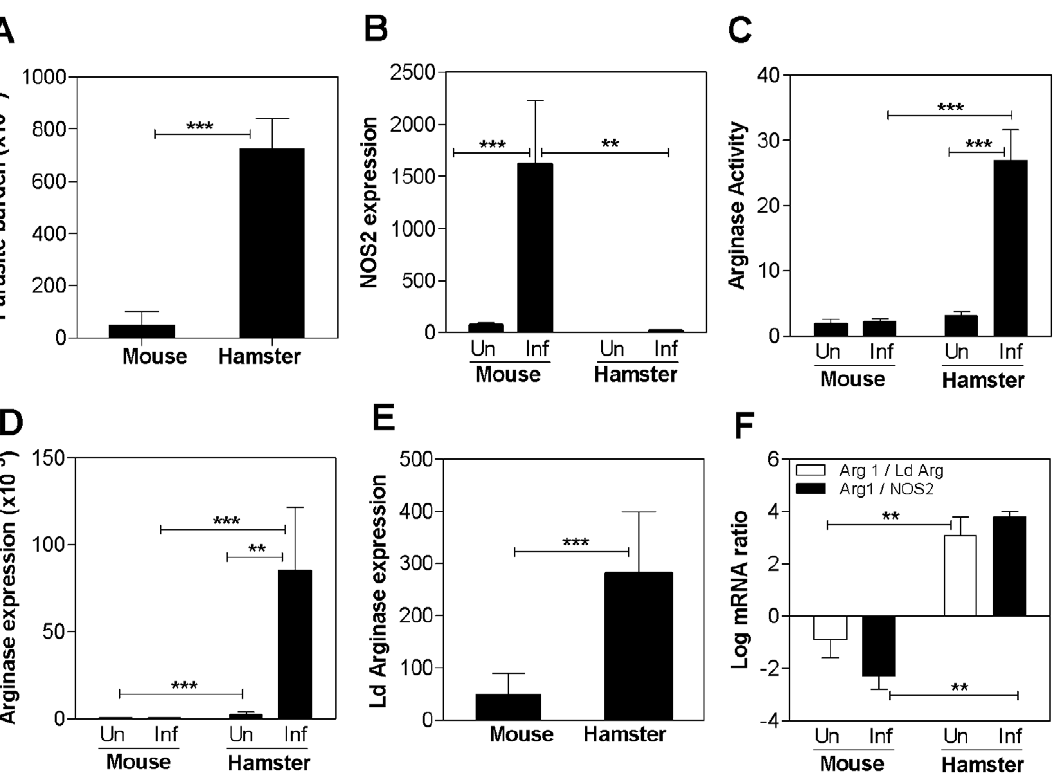
Figure 1. Dominant expression of arg1 in spleen tissue during progressive visceral leishmaniasis. A ) Parasite burden in the spleens of hamsters and mice (n=6 per group) infected with L. donovani -Luc for 6 weeks. The mean and standard deviation (SD) of the parasite burden, determined by luminometry and interpolation from a standard curve generated by enumeration and luciferase assay of amastigotes from the same tissue, is shown from a single experiment that is representative of 3 independent experiments. B ) Expression of NOS2 mRNA in spleens of uninfected (Un) and 6-week L. donovani infected (Inf) mice and hamsters (n=6 per group). The mean and standard error of the mean (SEM) of the fold-increase of NOS2 mRNA relative to BHK cells, determined by real time RT-PCR in 2 experiments is shown. C ) Arginase activity in spleens of uninfected (Un) and 6-week L. donovani infected (Inf) mice and hamsters (n=6 per group). The mean and standard deviation (error bars) of the tissue arginase activity, determined by assay of urea production, is shown from a single experiment that is representative of 3 independent experiments. D ) Expression of arg1 mRNA in spleens of uninfected (Un) and 4-week L. donovani infected (Inf) mice and hamsters. The mean and standard deviation (error bars) of the fold-increase of arg1 mRNA relative to BHK cells, determined by real time RT-PCR in groups of 7 animals, is shown from a single experiment that is representative of 2 independent experiments. E ) Expression of L. donovani arginase mRNA in spleens of 4-week L. donovani infected mice and hamsters. The mean and standard deviation (error bars) of the fold-increase of L. donovani arg1 mRNA relative to BHK cells, determined by real time RT-PCR in groups of 7 animals, is shown from a single experiment that is representative of 2 independent experiments. F ) Log 10 ratio of hamster arg1 mRNA to L. donovani arginase mRNA (open bars) and log 10 ratio of hamster arg1 mRNA to hamster NOS2 mRNA (filled bars) in the spleens of 4-week each of the panels is identified by asterisks (** p , 0.01; ***, p , 0.001).